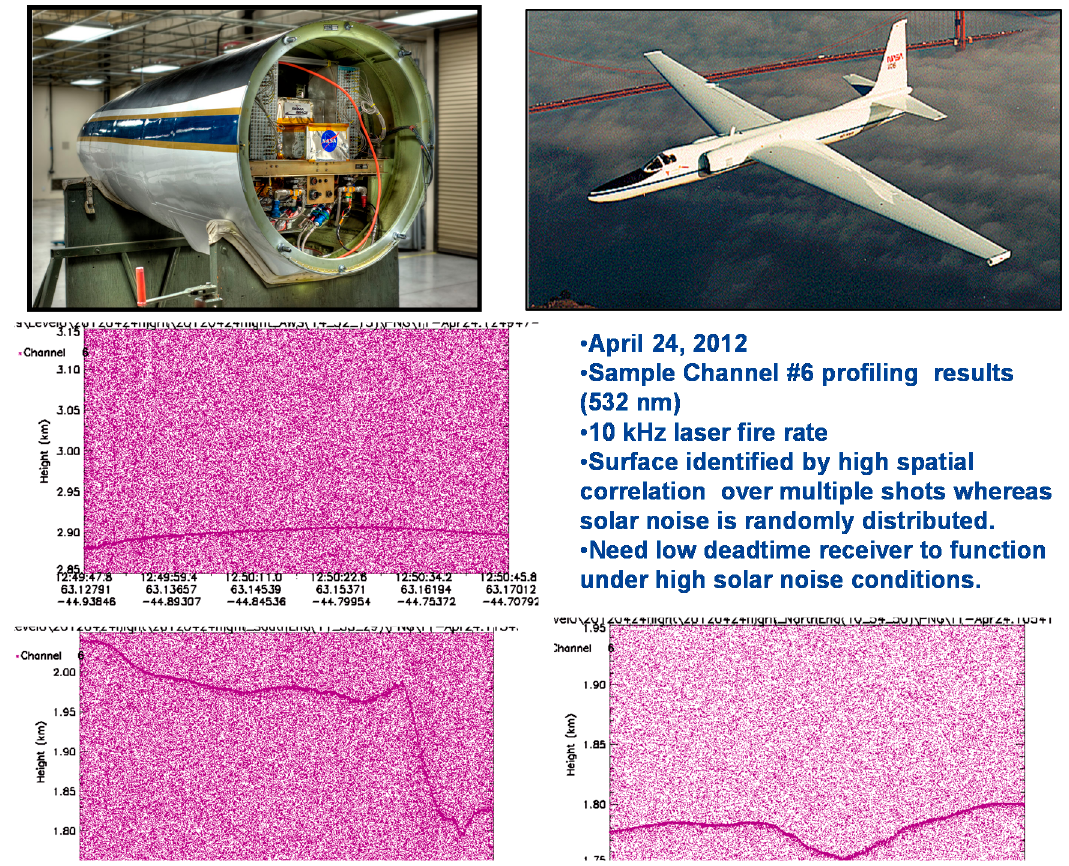
Figure 6. The NASA MABEL pushbroom lidar, jointly developed by NASA Goddard Space Flight Center and Sigma Space Corporation, has successfully generated 2D surface profiles in Greenland from an AGL of 20 km. The surface returns are highly spatially correlated and stand out against the dense “salt-and-pepper” solar noise background resulting from the high reflectance (typically 80% to 96%) of snow and ice at 532 nm.